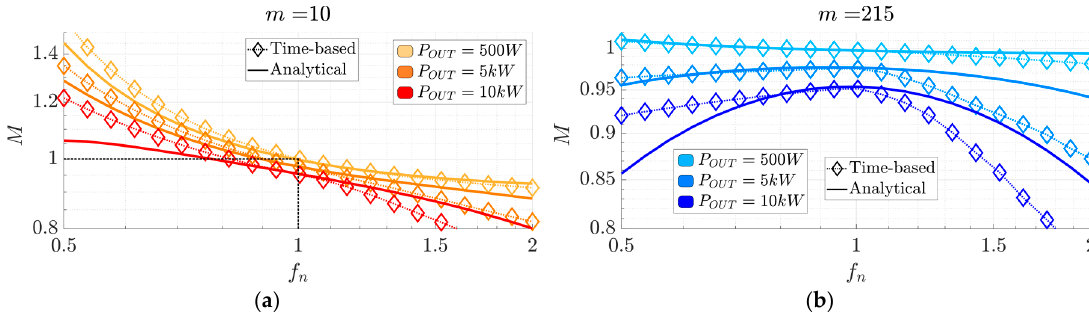
Figure 8. Comparison of the gain ( 𝑀 ) for the modified FHA and TB models (with simulation) with series resistance at different output powers ( a ) for 𝑚 = 10; ( b ) for 𝑚 = 215 .